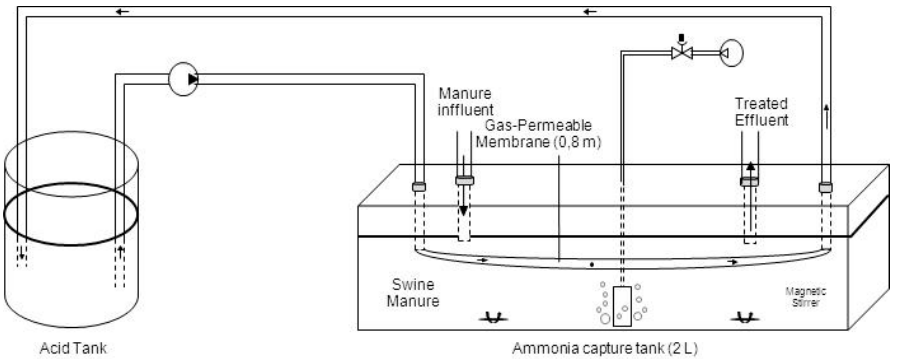
Figure 1. Process diagram of gas-permeable system operating at semi-continuous mode.